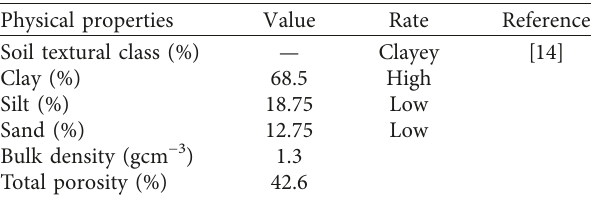
Figure 1: Location map of the study area. Table 1: Soil physical properties of the experimental site before